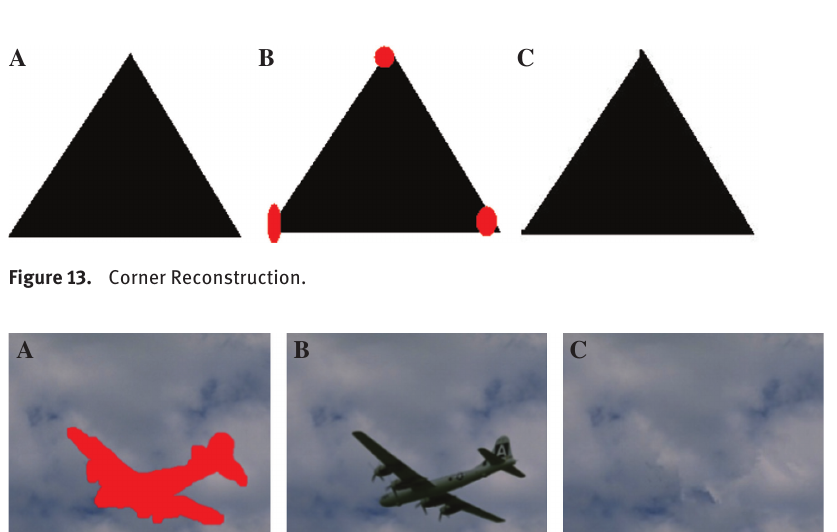
Figure 12. Image Repairing Example (Lenna): Patch Size 9 × 9.